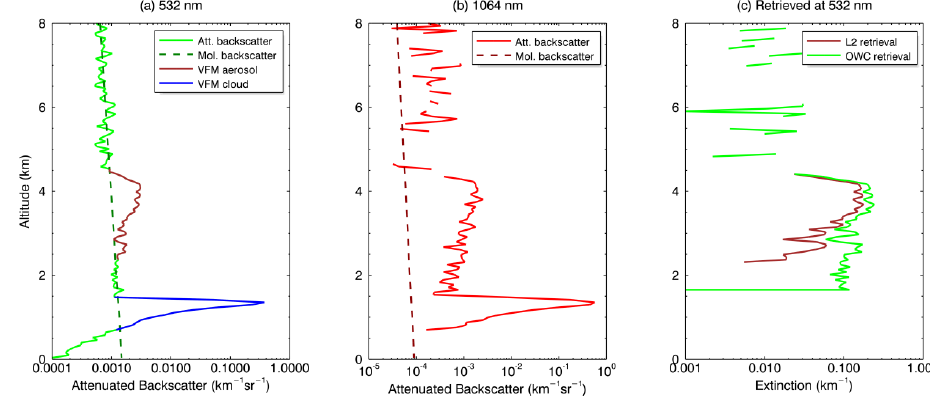
Figure 5. Solid curves in panel (a) and (b) show CALIOP attenuated backscatter profiles corrected for attenuation of molecular scattering and ozone absorption 532nm (a) and 1064nm (b) . The dashed lines in these panels show the corresponding molecular backscatter profiles. Panel (c) shows the aerosol extinction profiles at 532nm obtained from the standard L2 profile products (brown line) and retrieved in this paper using the OWC constrained technique (light green line). In both cases the retrievals were applied to a sequence of 5km averaged L1 profiles, which in turn were averaged further for 4 consecutive 5km profiles around 10 ◦ S, as shown in Fig. 4. Brown and blue coloring in panel (a) indicate the data segments detected as aerosol and cloud in the standard L2 data